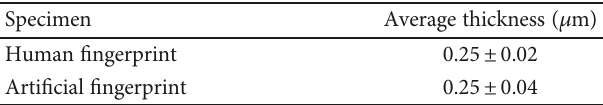
Figure 4: Images of water contact angles in di ff erent conditions: (a) glass/ITO 60.4 ± 4.2, (b) glass/ITO +real fi ngerprint 75.7 ± 1.2, (c) glass/ ITO+arti fi cial fi ngerprint 75.6 ± 3.3. Table 3: Average thickness measurements with confocal microscope of arti fi cial and human fi